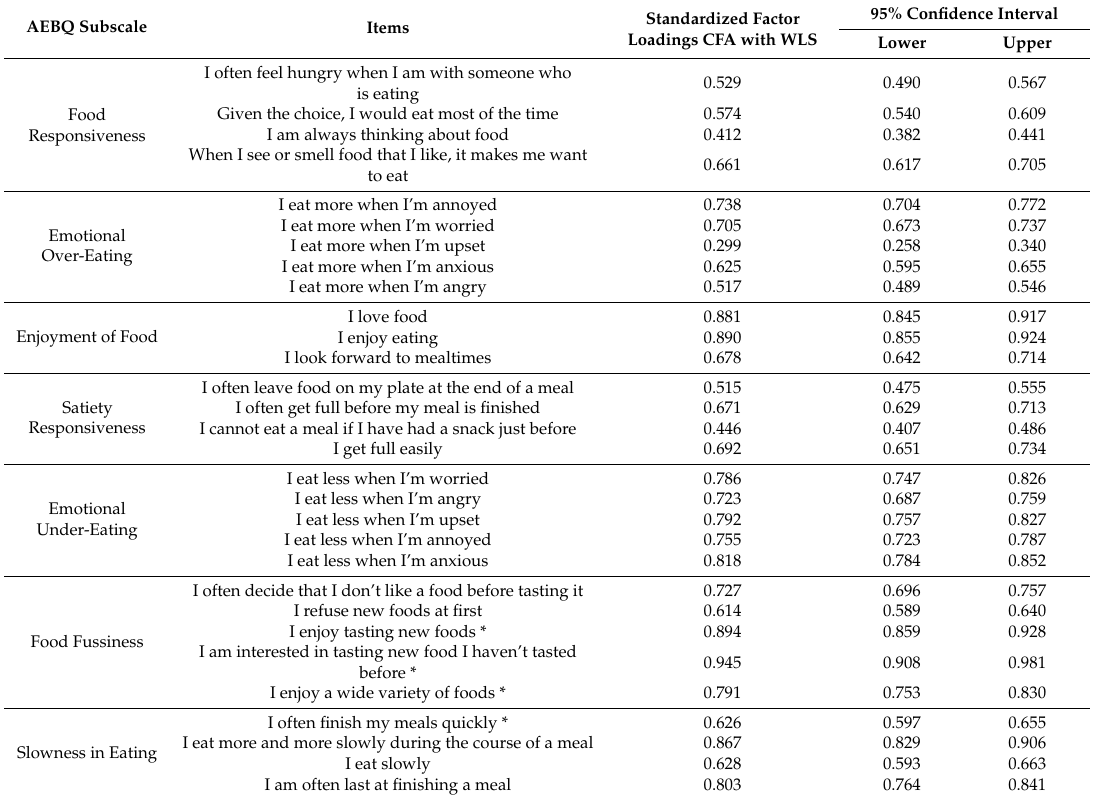
the Polish version of the AEBQ are presented in Supplementary Table S3. Table 3. Standardized factor loadings within the confirmatory factor analysis (CFA) with weighted least squares (WLS) obtained for the Polish version of the Adult Eating Behavior Questionnaire (AEBQ) ( n =